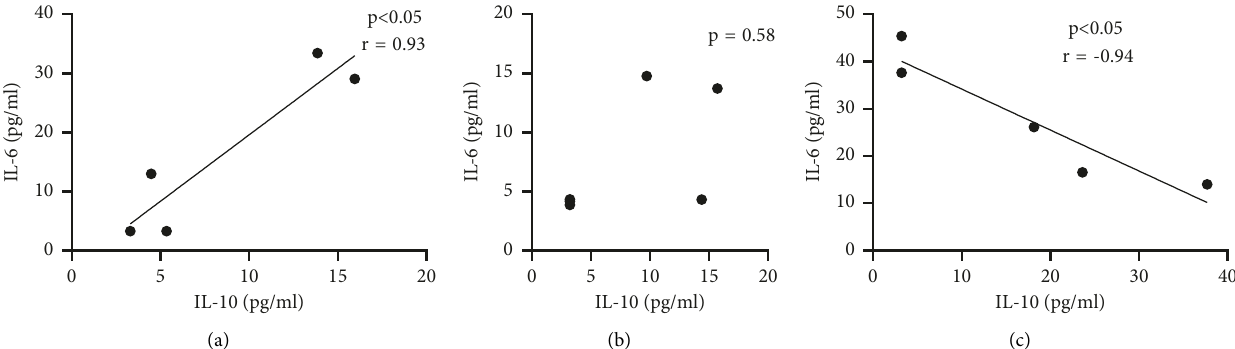
Figure 3: Correlation between IL-10 and IL-6 in the different patient groups. (a) Nonarthritic control (NC); (b) RA treatment na¨ıve (RATN); (c) RA treatment-nonresponding (RATNR). Statistical analysis: Pearson’s correlation. n � 5 per